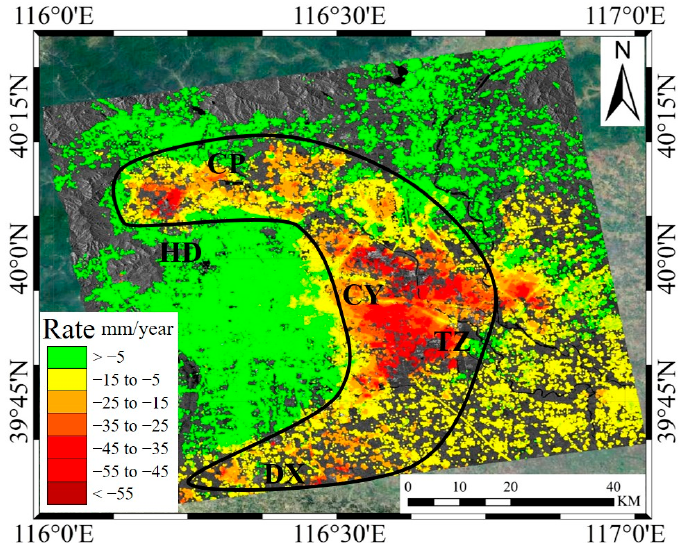
Figure 4. Surface subsidence rate in Beijing from January 2018 to March 2020 (before the COVID-19 outbreak). ‘CP’ is Changping District, ‘HD’ stands for Haidian District, ‘CY’ is located in Chaoyang District, ‘TZ’ means Tongzhou District and ‘DX’ is Daxing District.